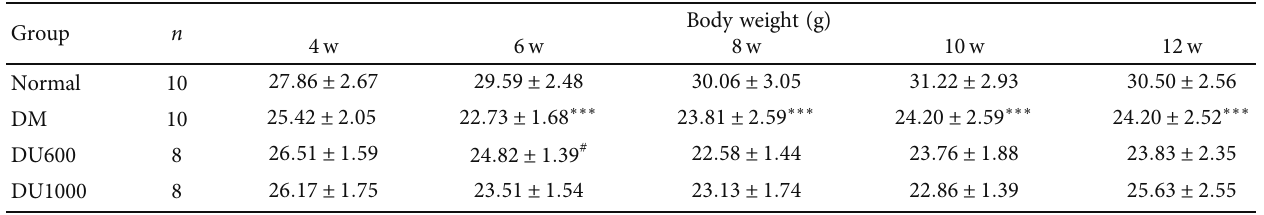
Table 1: Metabolic indexes of mice. (a) Body weight changes of mice in each week. (b) Blood glucose changes of mice in each week. (c) Blood lipid index changes of mice. (a) Body weight changes of